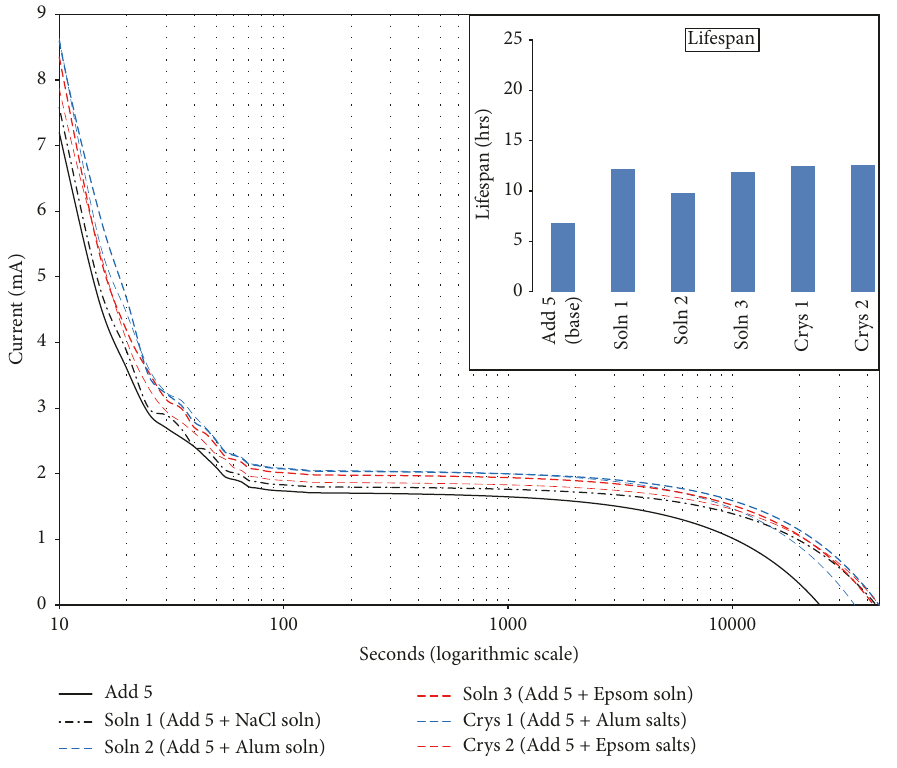
Figure 10: Current discharge curves across a 10 Ω resistor for different salts.